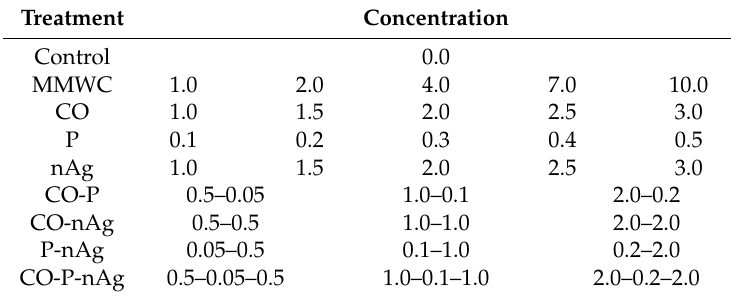
Table 1. Concentrations used in the in vitro experiments (medium molecular weight chitosan (MMWC), COs and P are given in mg · mL − 1 , and that of nAg in µ g · mL − 1